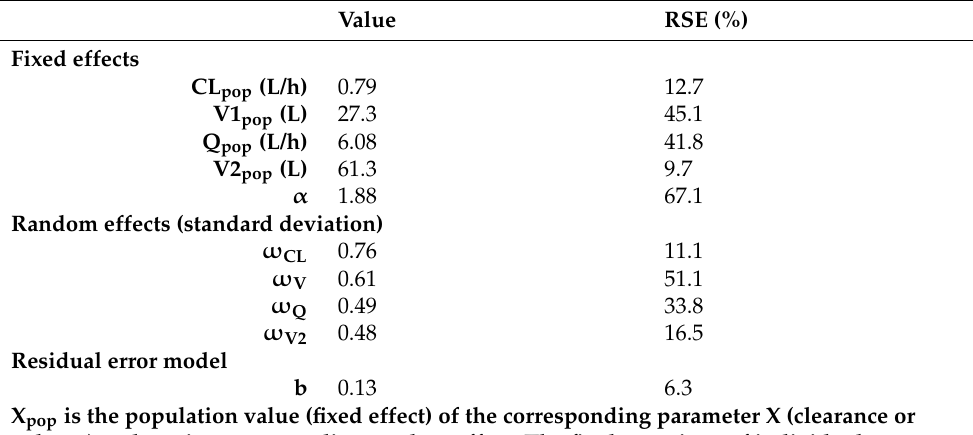
Table 2. Estimates of pharmacokinetic parameters of the final model.